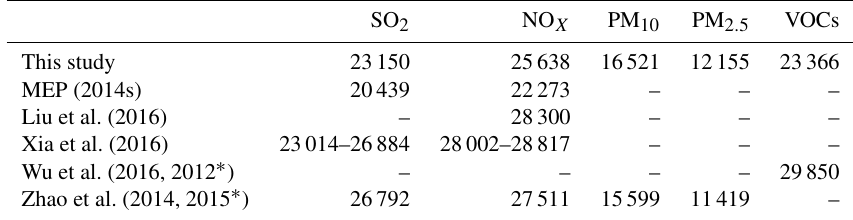
Table 7. Comparisons with other studies on recent air pollutant emissions in China (in kilotons).